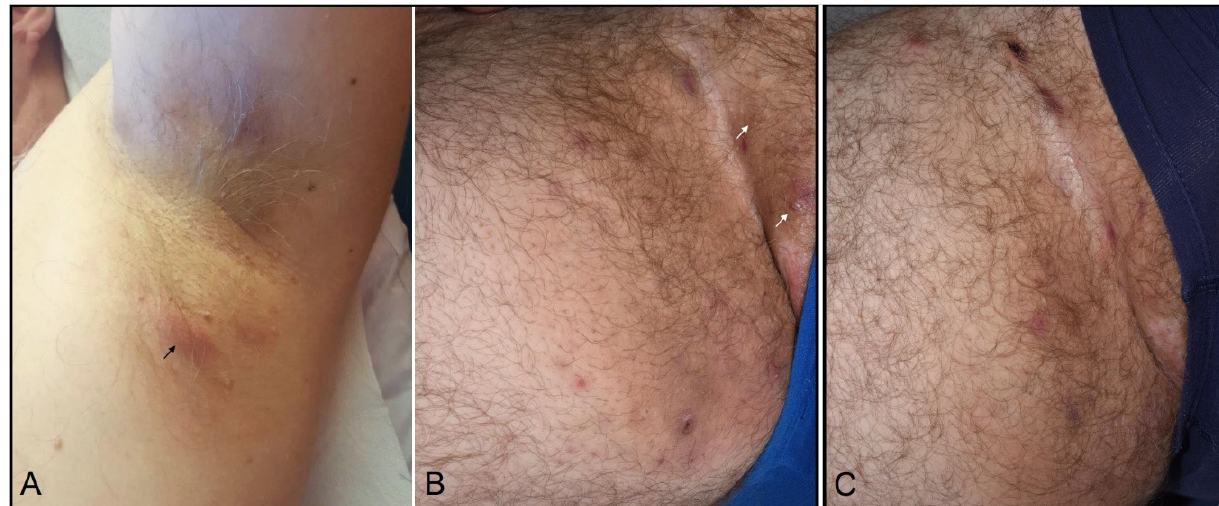
Figure 1. HS palpable nodules and aseptic abscess still occurring in the axillary folds ( A ) and the groins ( B ) four months after anti-PD-1 therapy discontinuation (arrows). ( C ) Remaining surgical drainage-induced scars ten months after adjuvant therapy discontinuation.